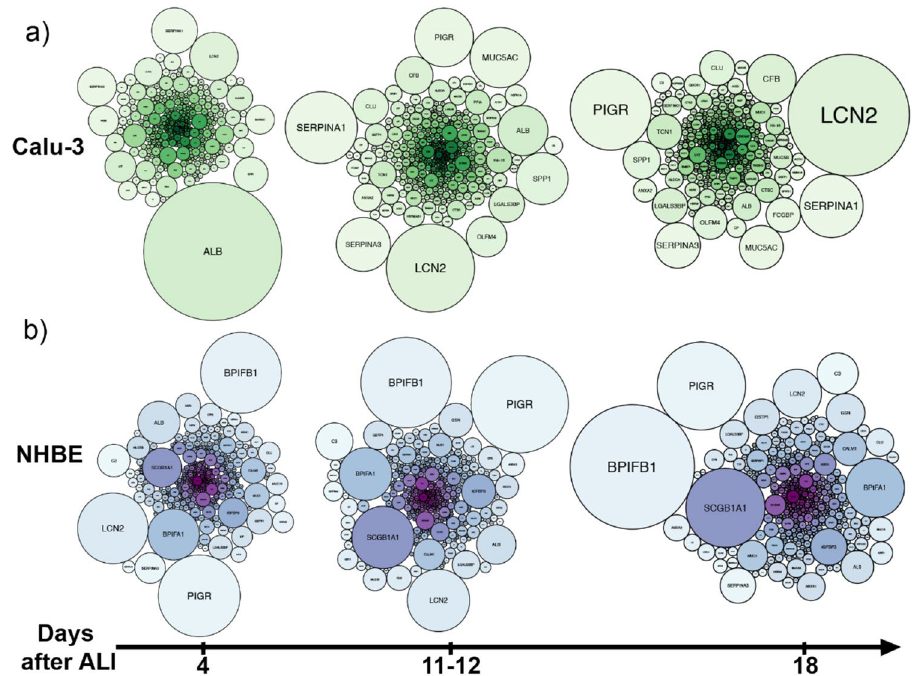
Figure 4. Time evolution of the secretome of Calu-3 and NHBE cells. Schematic representing the proteins secreted by Calu-3 ( a ) and NHBE ( b ) cells as a function of their abundance at day 4, 11–12, and 18 after ALI. A larger sphere denotes a higher protein abundance. Proteins are designated by their corresponding gene. Human serum albumin ( alb ), neutrophil gelatinase-associated lipocalin ( lcn2 ), polymeric immunoglobulin receptor ( pigr ), alpha-1-antitrypsin ( serpina1 ), BPI fold containing family B member 1 ( bpfib1 ). The full protein list is detailed in Table